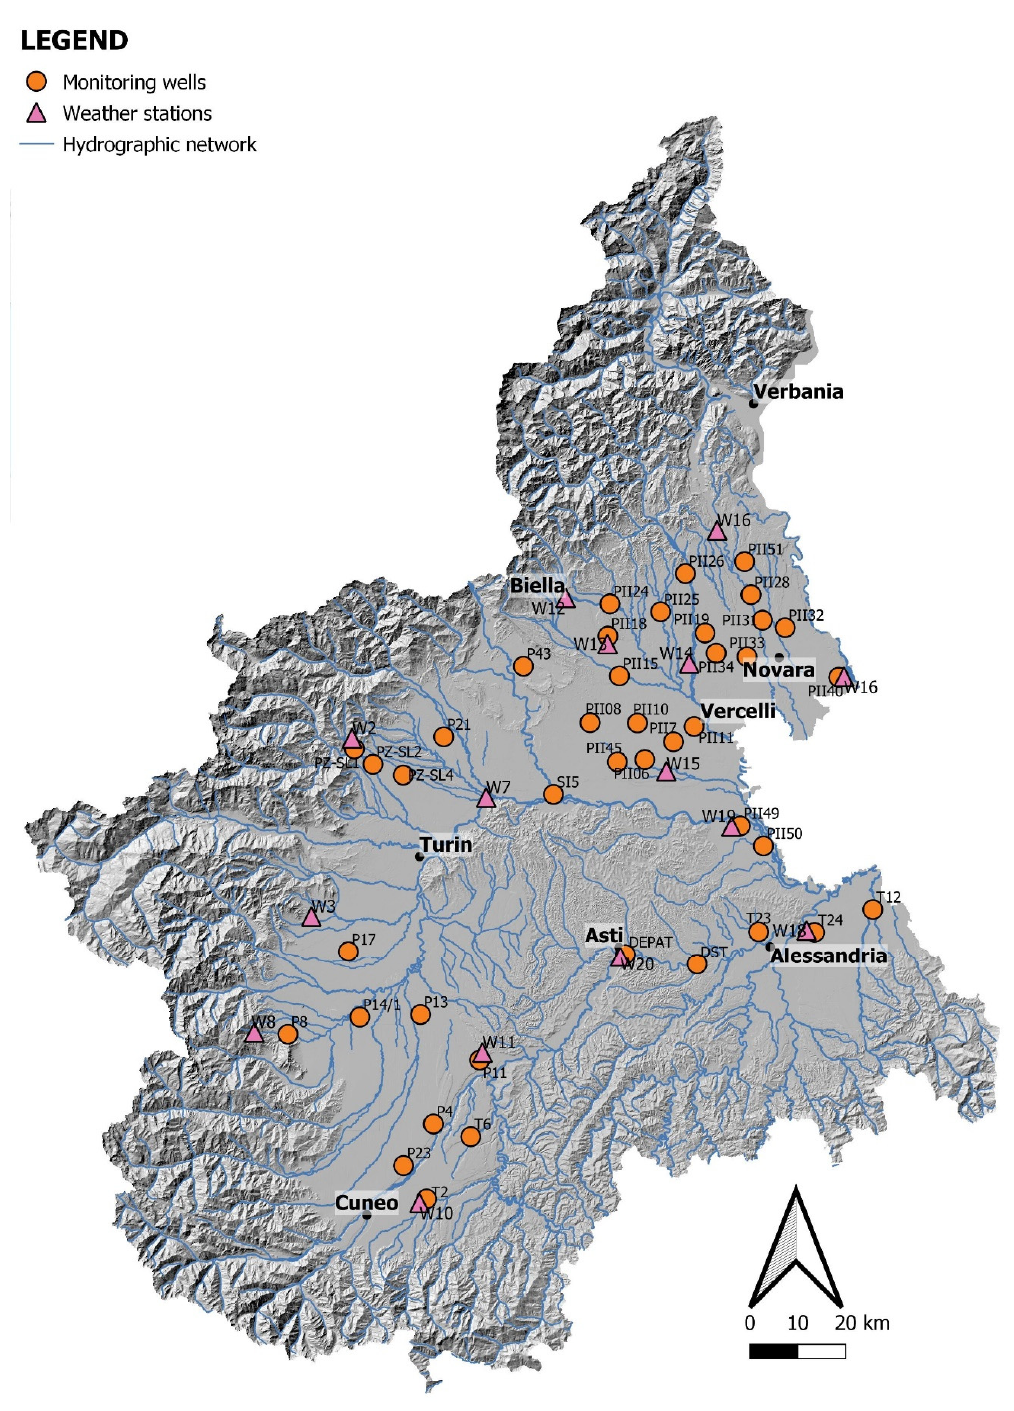
Figure 2. Map of the Piedmont region with the localization of the 41 monitoring wells and the 20 weather stations used for the study.